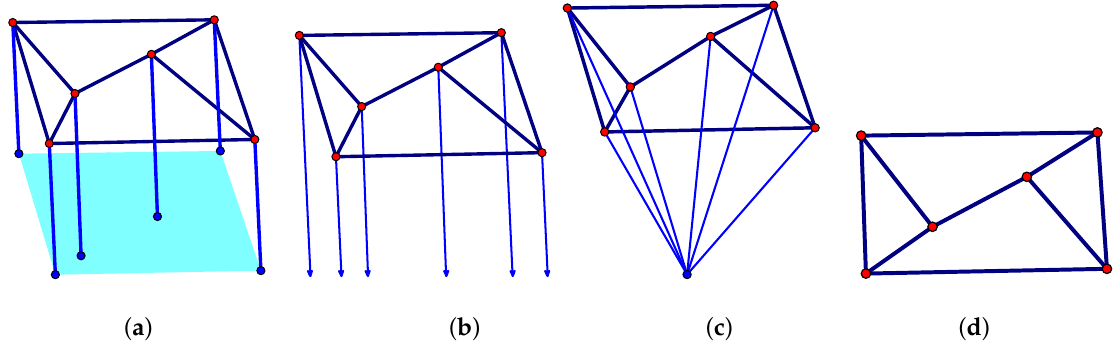
Figure 13. A 1-story building is essentially a cone ( a – c ). The rigidity of the roof depends on the projection ( d ) in the vertical